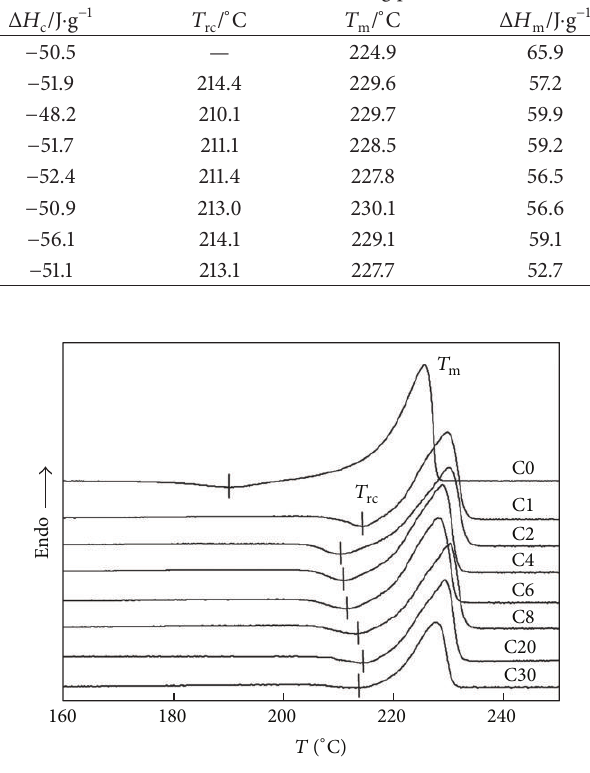
Figure 7: DSC melting curves for different PTT/CaCO 3 nanocom-